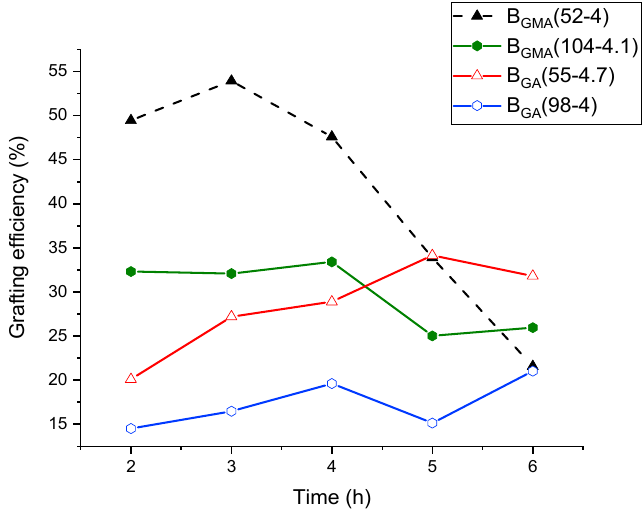
Figure 6. Grafting e ffi ciency of blends through the reaction course.